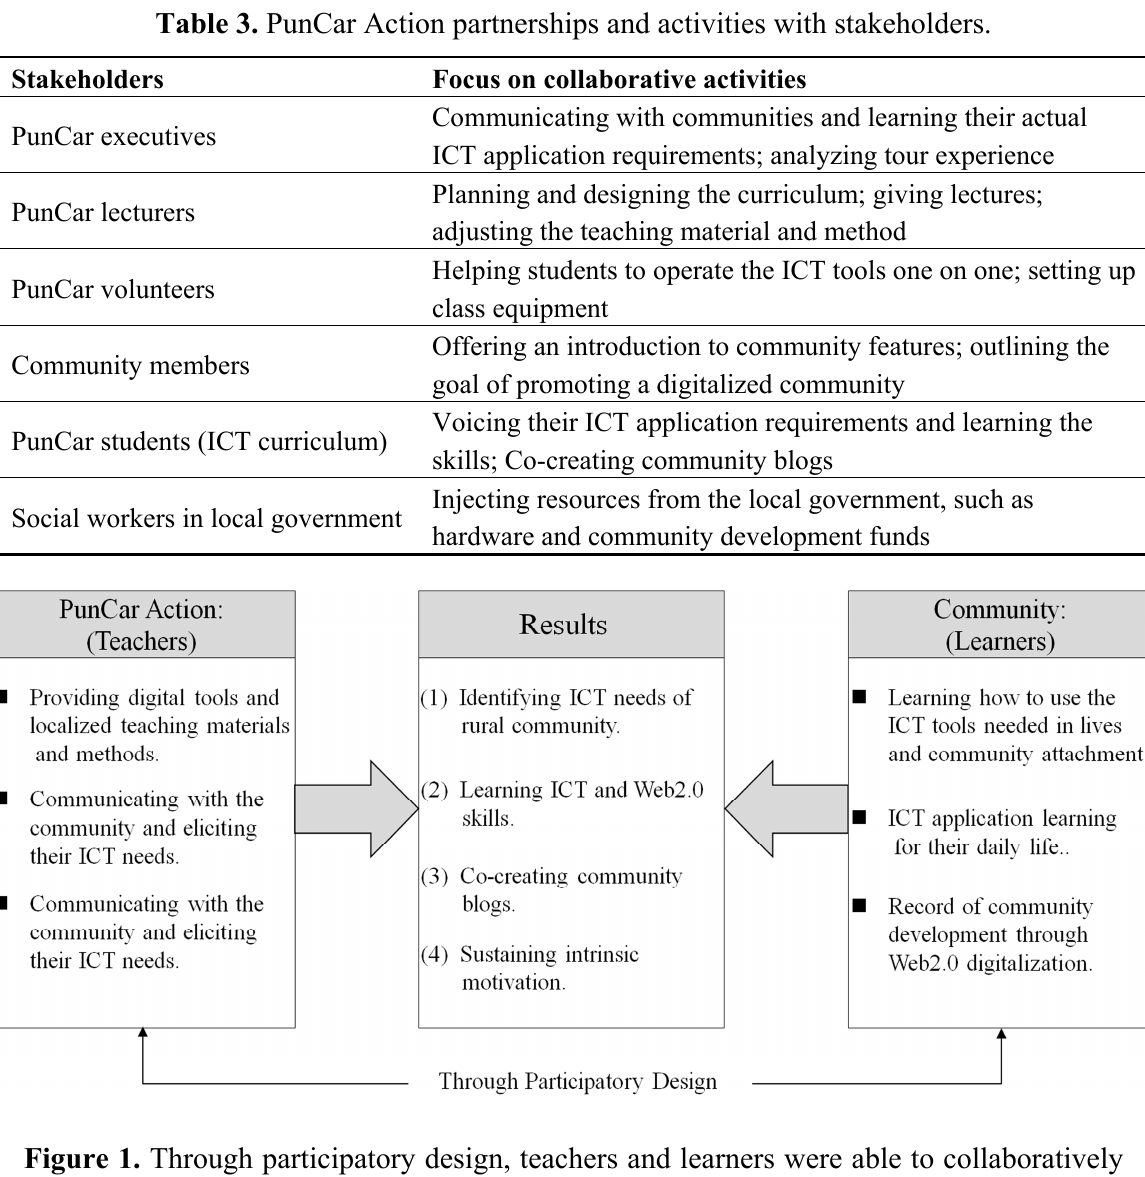
Figure 1. Through participatory design, teachers and learners were able to collaboratively plan the Information Communication Technology (ICT) curriculum and lecture mode most suitable for the